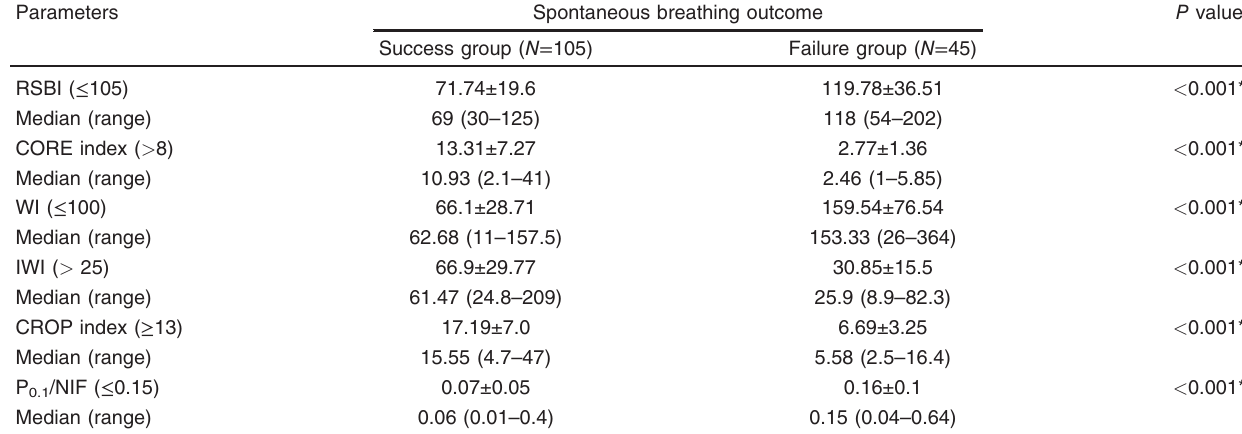
Table 3 Comparison between different weaning indices as regards weaning success or failure